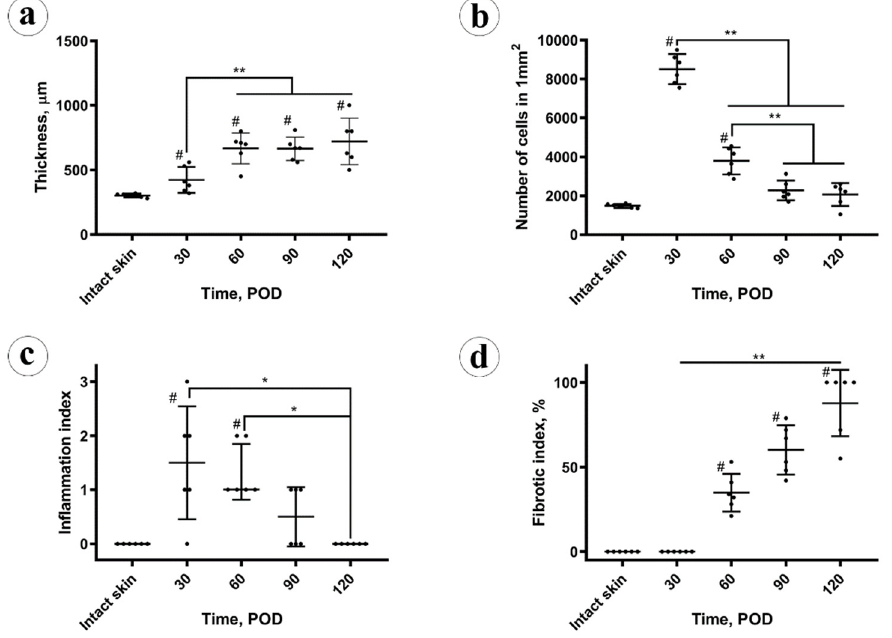
Figure 1. Morphometry analysis. ( a ) Thickness of the dermal parts of the intact skin and experimental scars; ( b ) cellular density; ( c ) inflammation index; ( d ) fibrotic index. Statistical significance: * p ≤ 0.05, ** p ≤ 0.01, # shows p ≤ 0.05 in comparison to control.